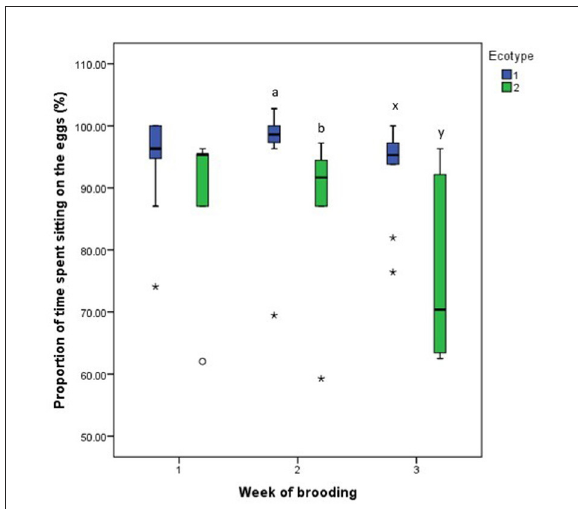
FIGURE4 Proportion of time spent by two Nigerian indigenous hen ecotypes (1 = Yoruba and 2 = Fulani) turning the eggs over the three weeks of brooding. Outlier in the data is depicted by the symbol “*”.